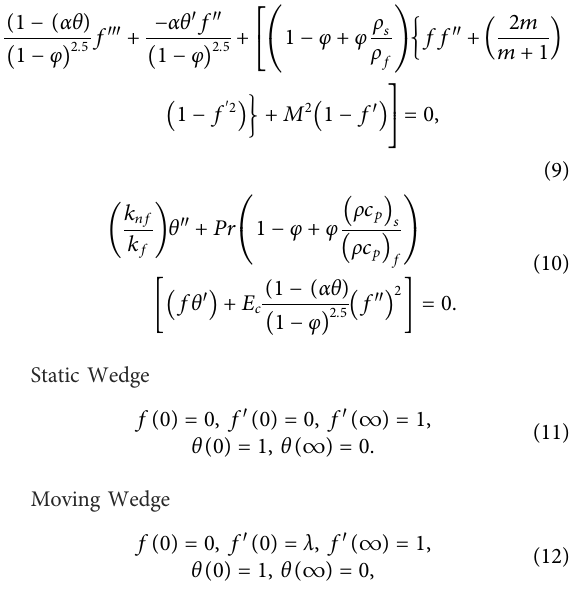
FIGURE 2 (A – C) Velocity pro fi les corresponding to multiple nano fl uidic fractions: (A) ( α ), (B) ( M ), and (C) ( m ).